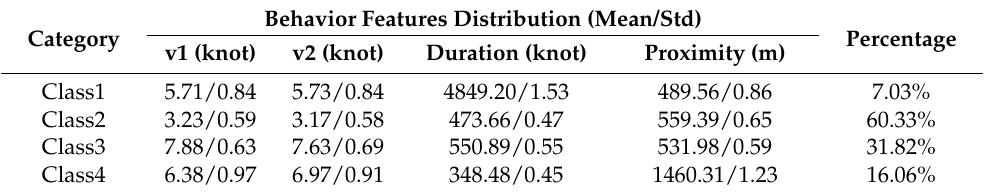
Table 9. Unsupervised clustering model of Rizhao, China dataset.